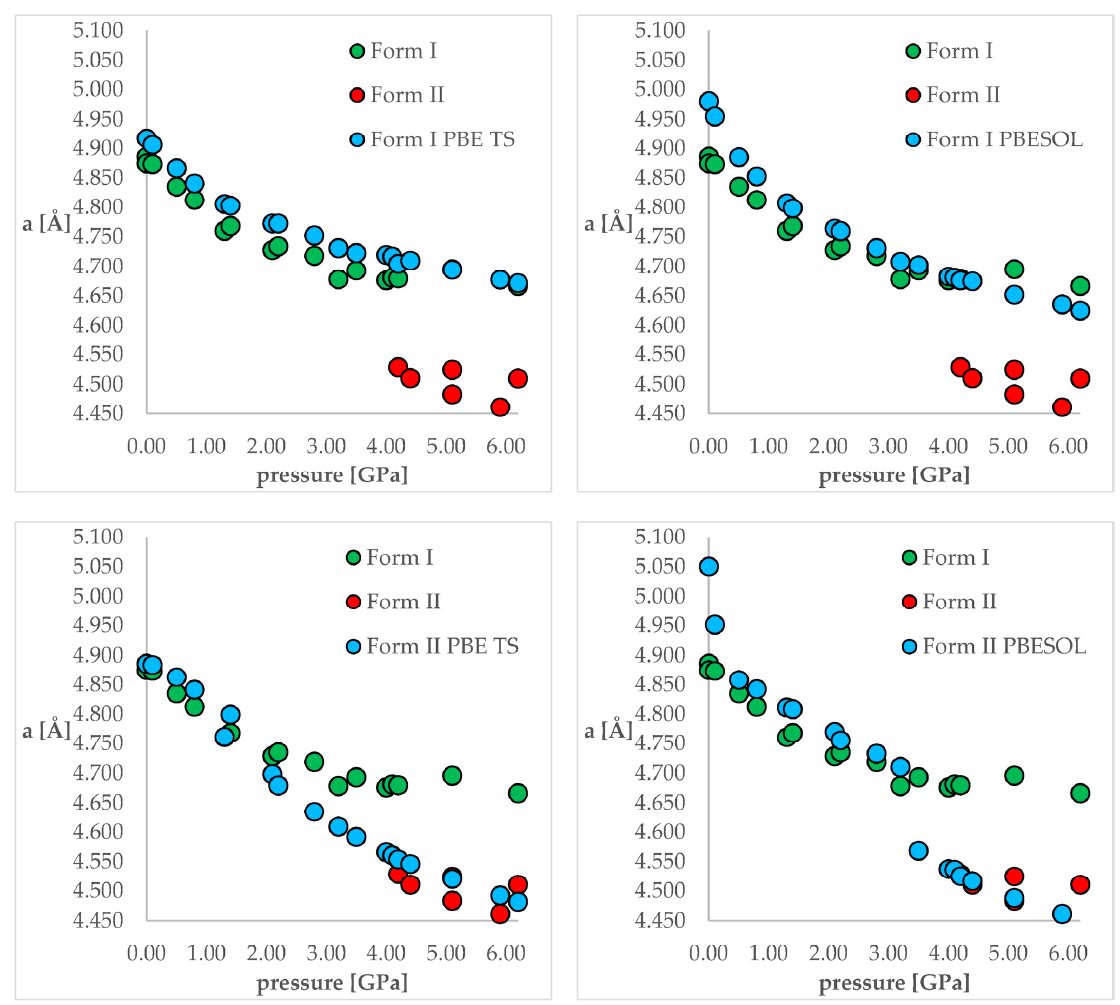
Figure 3. The change of unit cell edge “a” length with respect to pressure. Green circles—experimental Form I; red circles— experimental Form II; blue circles—calculated ones. Top left —using PBE TS and starting from Form I; top right —using PBESOL and starting from Form I; bottom left —using PBE TS and starting from Form II; top right —using PBESOL and starting from Form